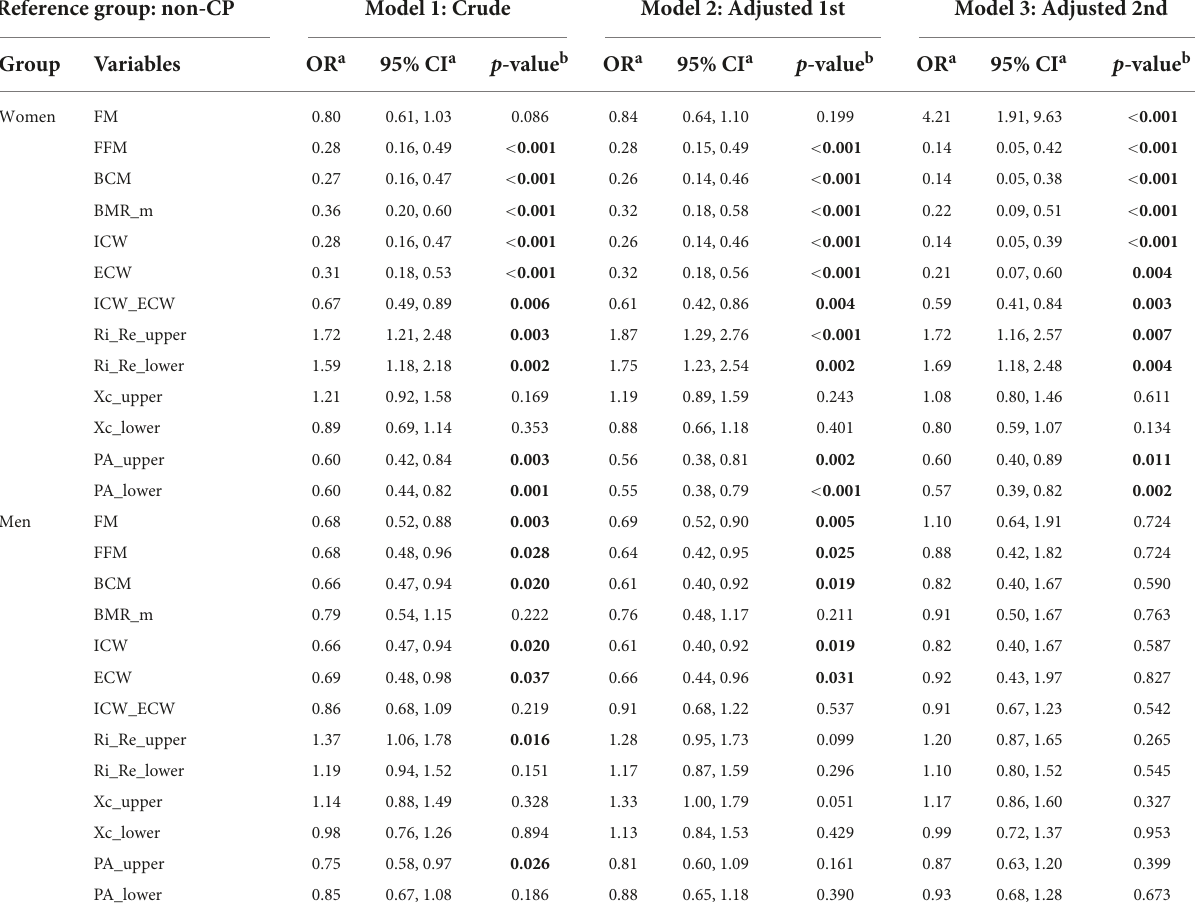
TABLE 3 Estimated odds ratios and their 95% confidence intervals derived from three logistic regression models in women and